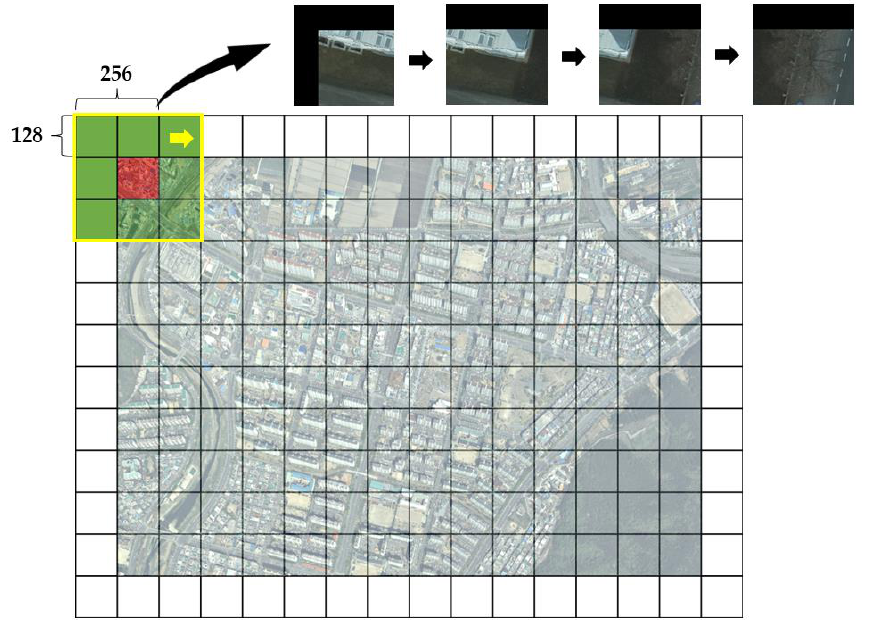
Figure 9. Example of the edge padding cutting